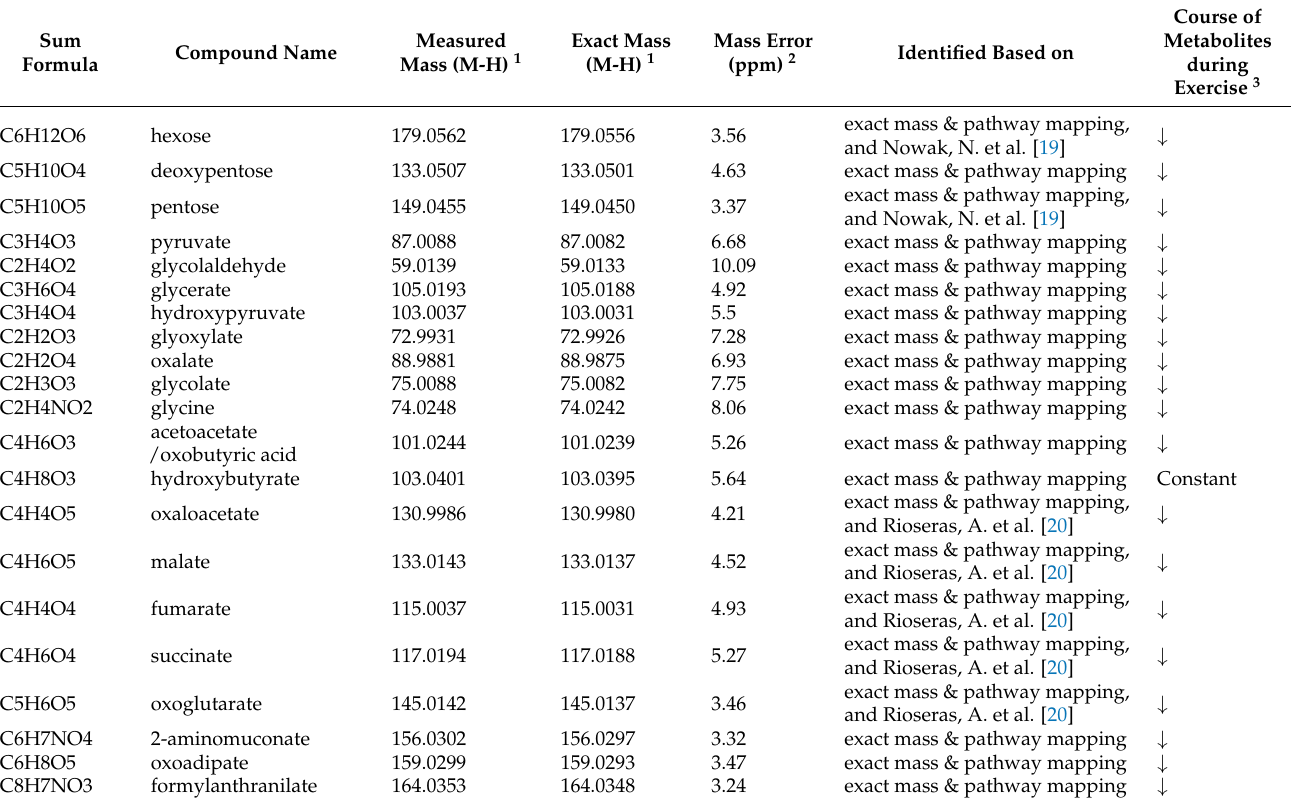
Table 2. Identification state of exhaled